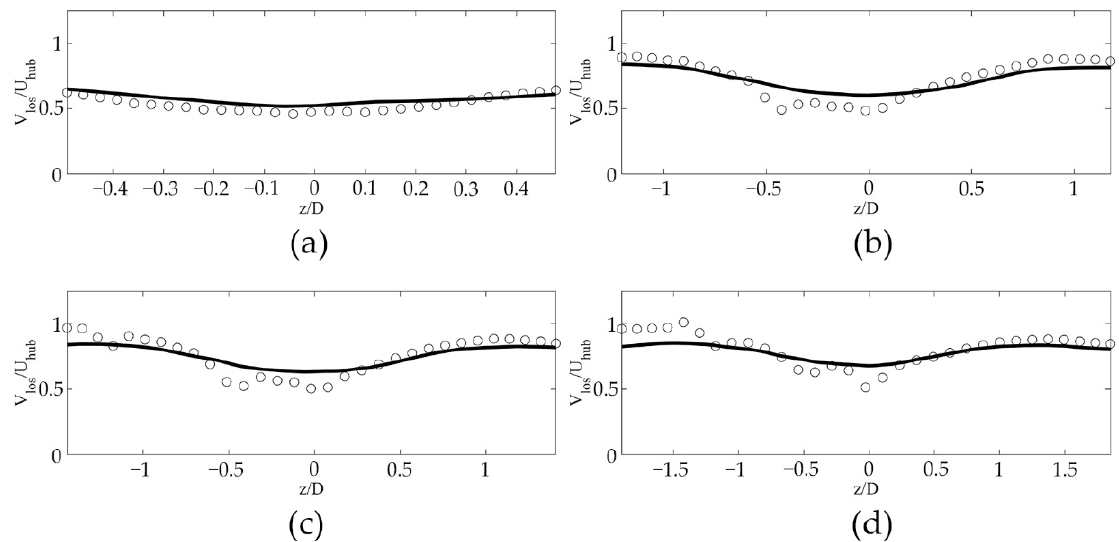
Figure 5. Time-averaged line-of-sight velocity: ( ⚬ ) SpinnerLidar and ( ⎯ ) numerical LiDAR from the LES; ( a ) 1 𝐷 , ( b ) 2 𝐷 , ( c ) 3 𝐷 , and ( d ) 4 𝐷 behind the wind turbine.